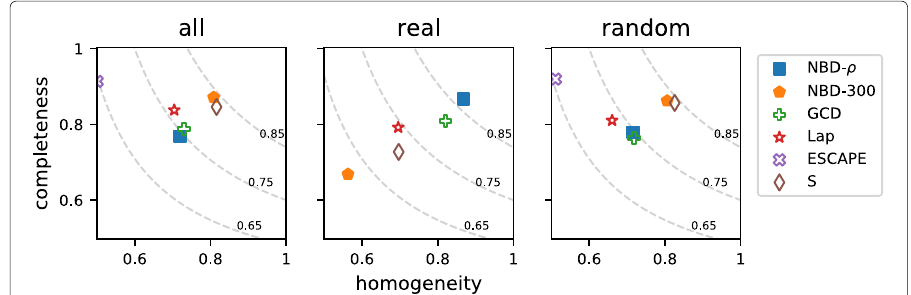
Fig. 8 Evaluation of spectral clustering. Results of clustering all data sets using spectral clustering. Homogeneity measures the diversity of ground-truth data sets that are clustered together; completeness measures the diversity of clusters assigned to the networks belonging to the same data set; see “Clustering networks” section for definitions. We plot the average homogeneity and completeness values of the clusterings obtained from applying spectral clustering, using each distance method in turn, over all networks (left), only real networks (middle), and only random graphs (right). Gray guide lines mark the set of points with the same v-measure (the iso-v-measure curves). ESCAPE not shown in middle panel due to poor performance (v-measure =